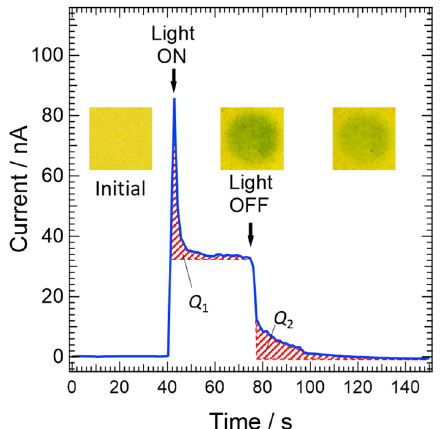
Figure 9. Time evolution of photocurrent in PHIG with a constant 0.5 V bias. “Light ON” represents the time when irradiation with white light was started and “Light OFF” represents the time when irradiation with white light was turned off. The inset photos are of PHIG taken under the same measurement conditions but the photo on the right was taken about 30 min after irradiation was terminated. Ionic liquid [Bmim]Br was used to obtain